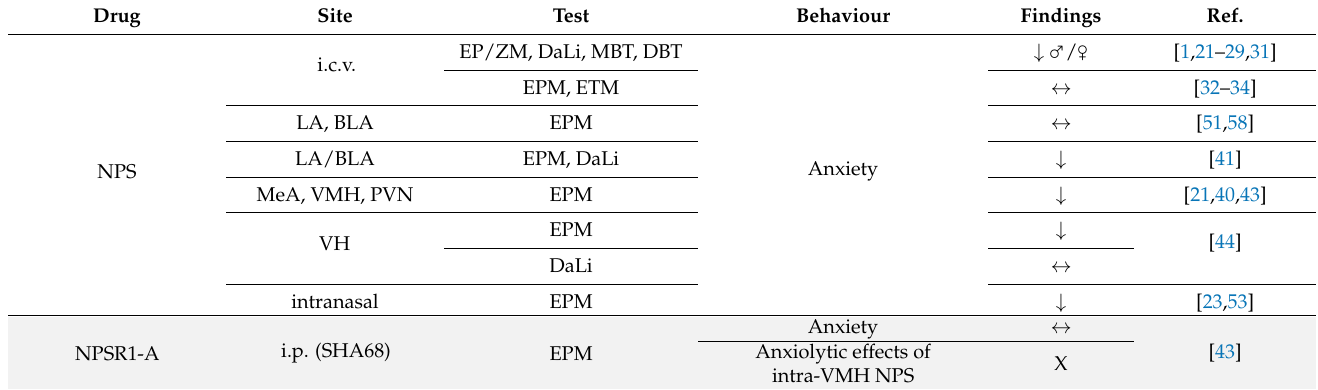
Table 1. Summary of the preclinical studies showing the role of the NPS/NPSR1 system in stress-relevant behaviours and